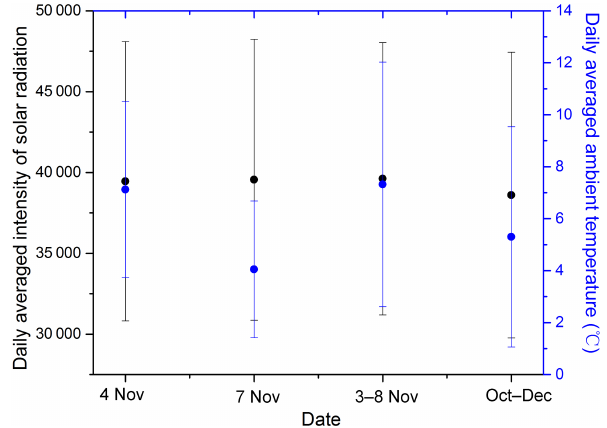
Figure 8. Averaged intensity of solar radiation and temperature in the four periods of 4, 7, 3 to 8 November, and 1 October to 31 De- cember 2014. Error bars denote the standard